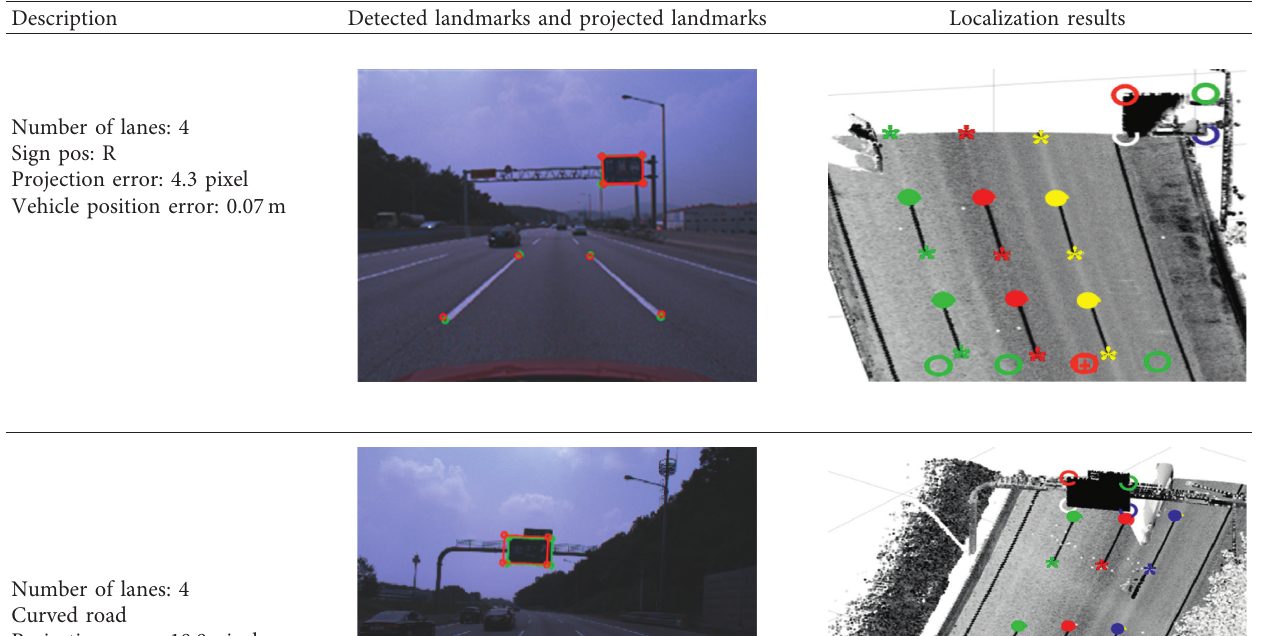
Table 7: Vehicle localization results of the proposed method in various